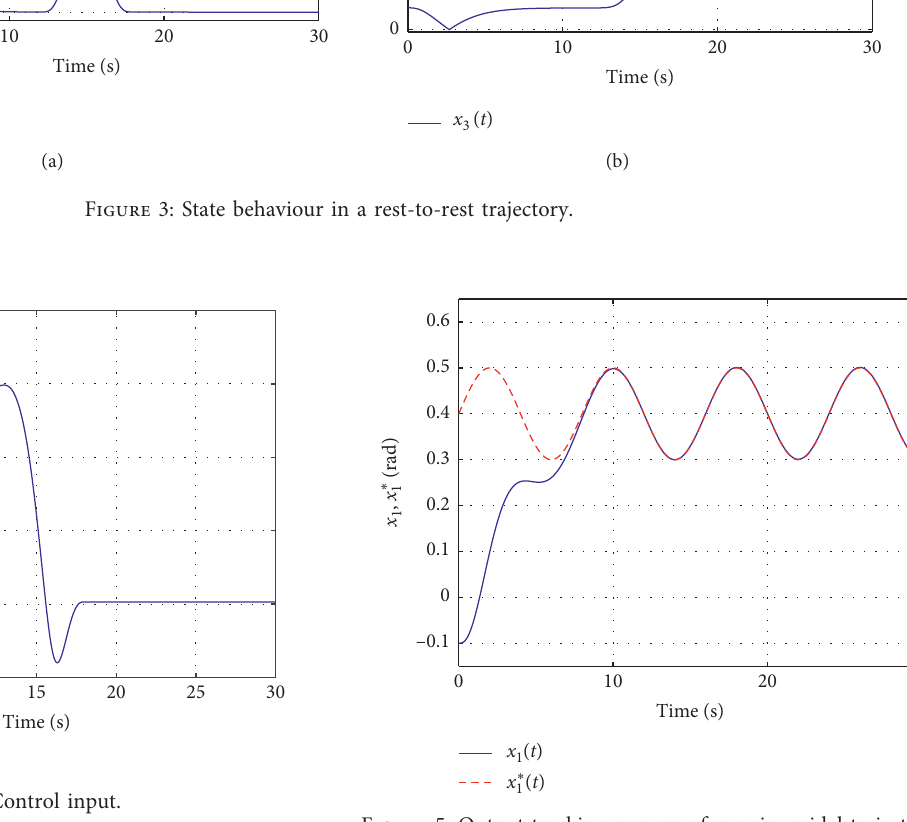
Figure 5: Output tracking response for a sinusoidal